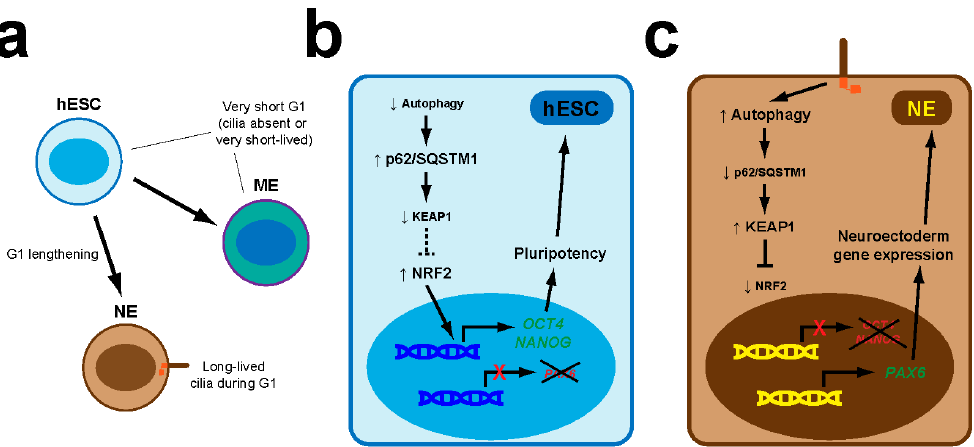
Figure 3. The primary cilia-autophagy-NRF2 (PAN) axis controls neuroectoderm specification in hESCs. ( a ) hESCs divide rapidly and their G1 cell cycle phase is too short for primary cilia to appear (if they do, they are quickly disassembled before the next cell division). As hESC offspring begin the process of neuroectoderm (NE) lineage specification, G1 lengthens, allowing primary cilia to form for longer periods. Such G1 lengthening does not occur in the early phases of mesendoderm (ME) specification. ( b ) In hESCs, autophagy levels are low, allowing p62/SQSTM1 to accumulate and promote KEAP1 degradation. As a result, NRF2 activity is high and promotes expression of pluripotency genes like OCT4 and NANOG , which block induction